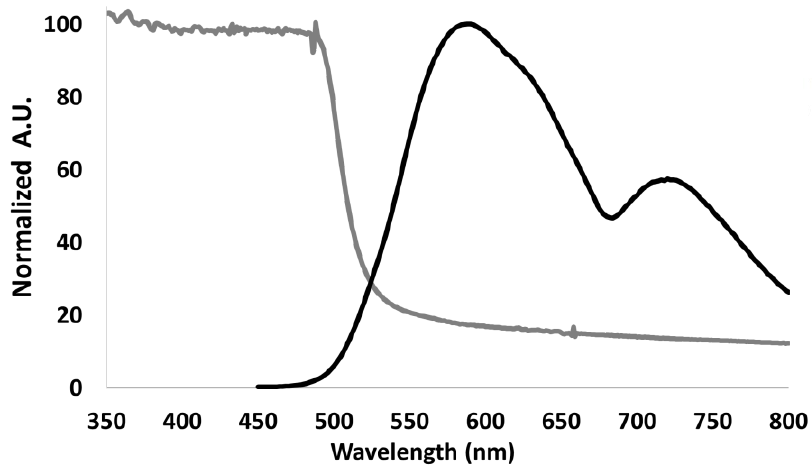
Figure 4. Absorption (gray) and emission (black) spectra of